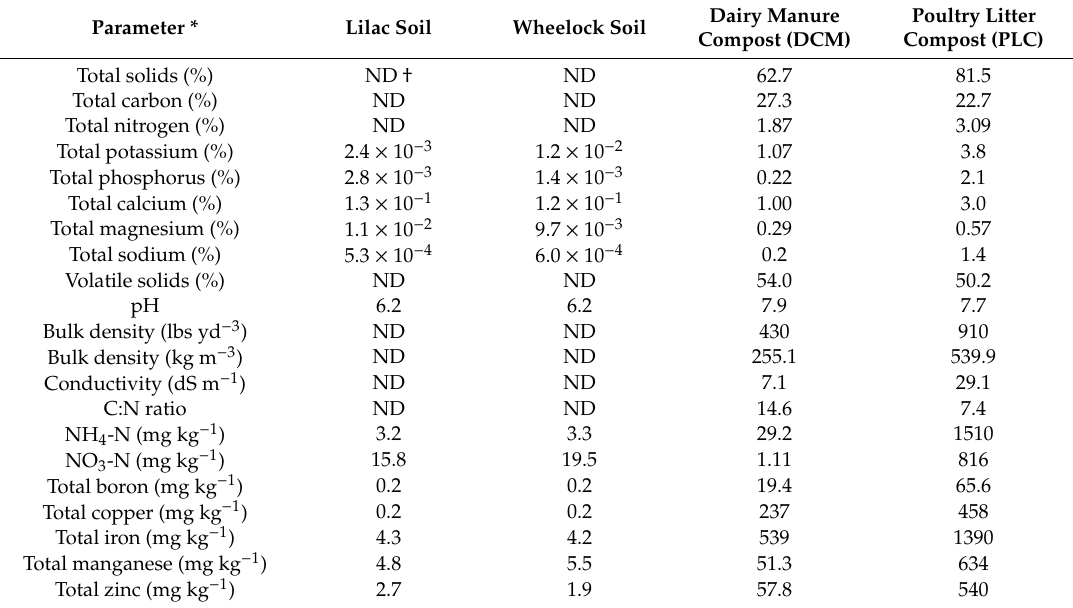
Table 1. Soil chemistry before the treatment applications and the properties of compost treatments. Parameter *